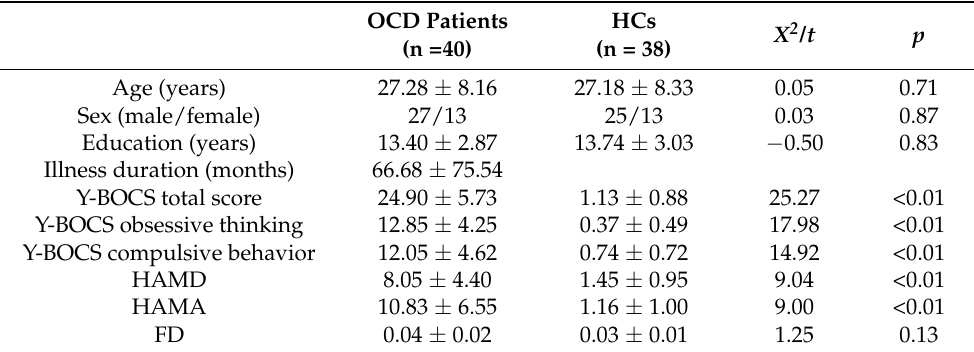
Table 1. Sociodemographic and clinical characteristics of participants.